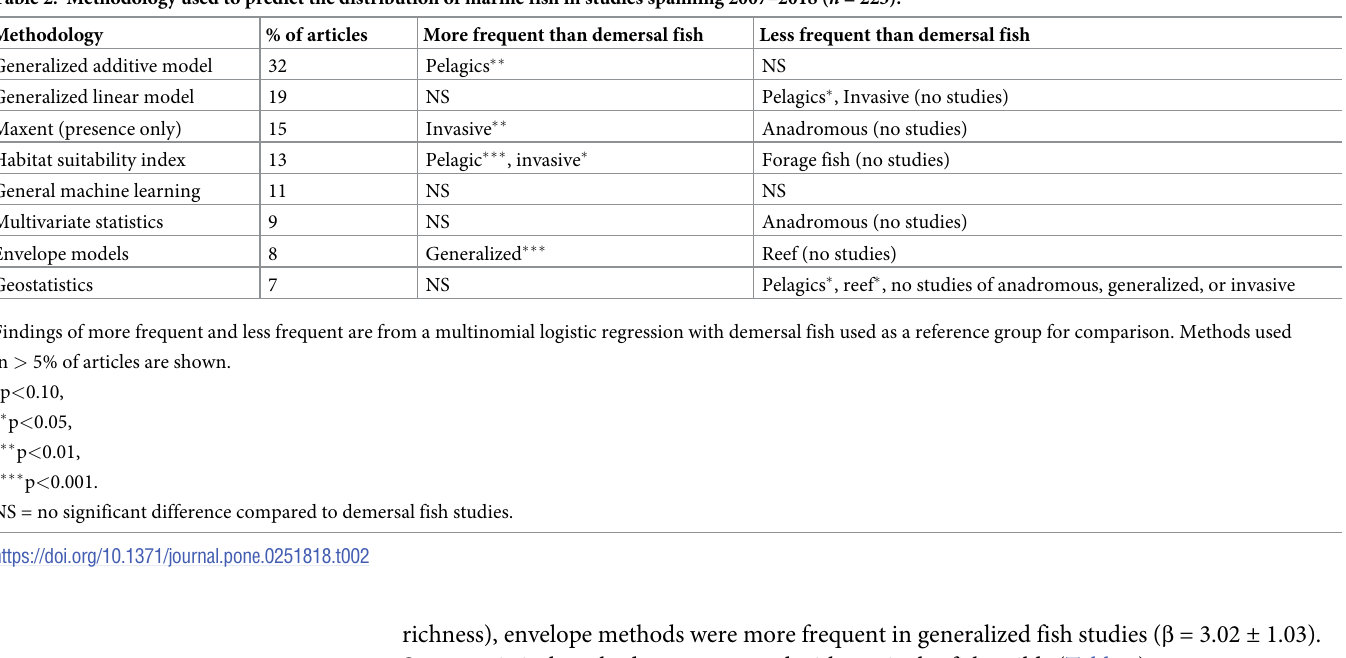
Table 2. Methodology used to predict the distribution of marine fish in studies spanning 2007–2018 ( n =